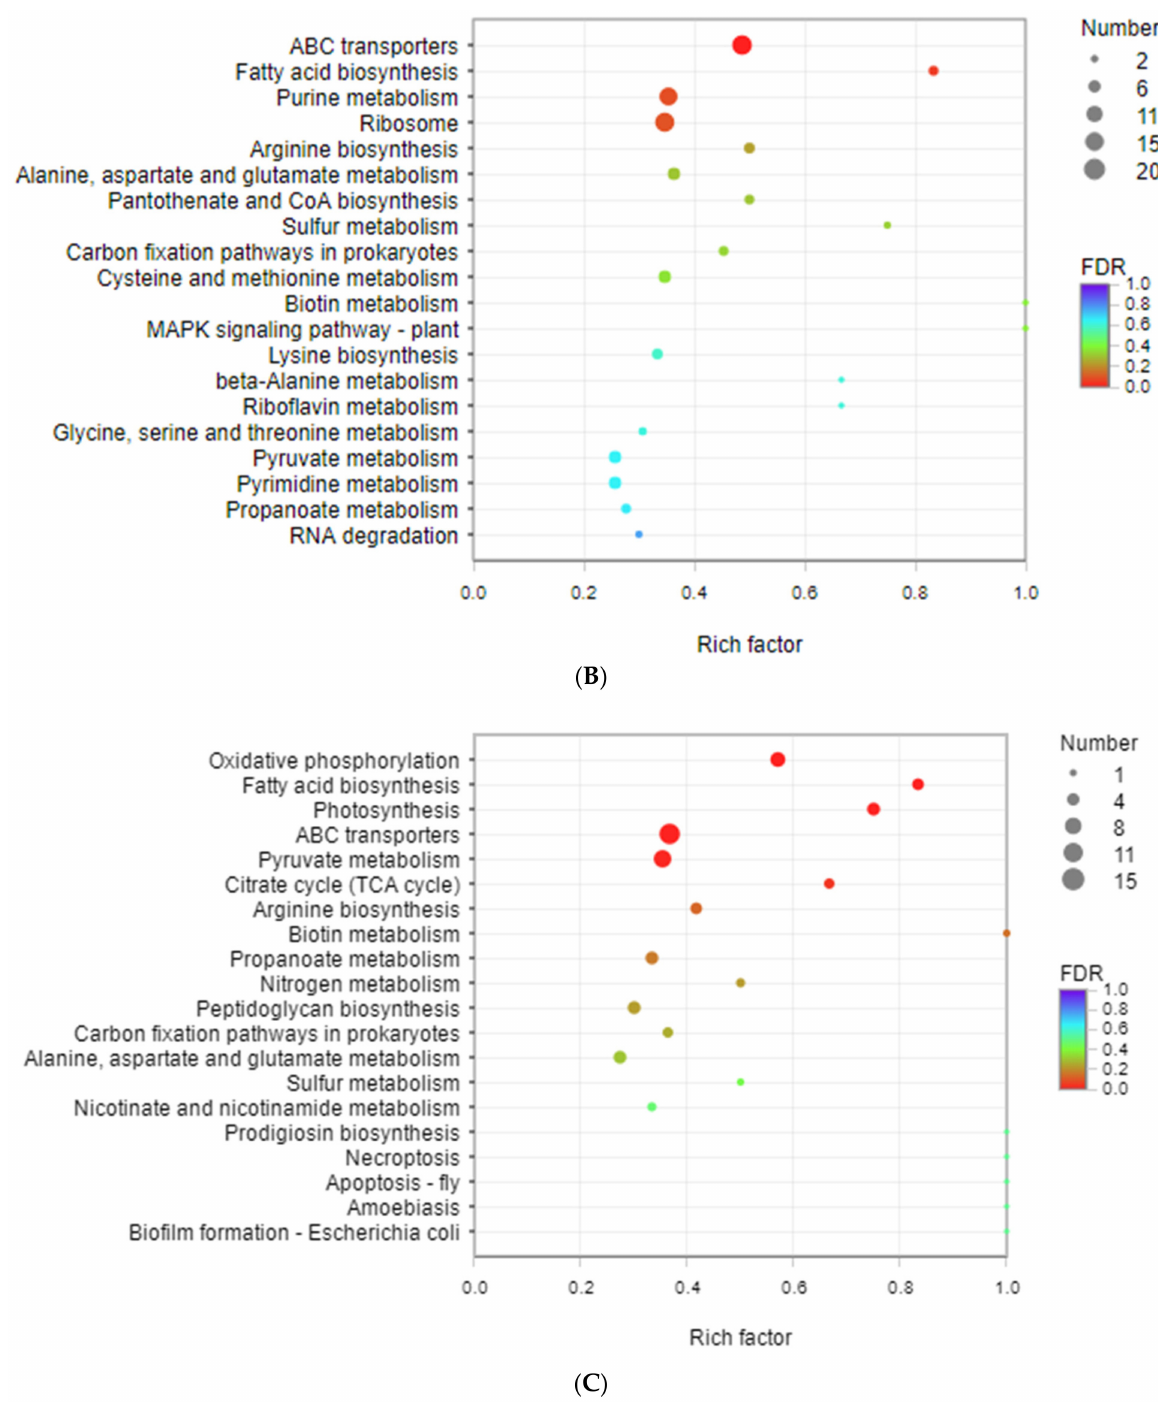
Figure 4. KEGG enrichment analysis of different comparisons ( n = 3). ( A ) dpro/MRS; ( B ) dpep/MRS; ( C ) dpep/dpro. The vertical axis represents the name of the pathway and the horizontal axis represents the ratio of the Rich factor. The size of the dot indicates the number of genes enriched in this pathway, and the color corresponds to different Q value